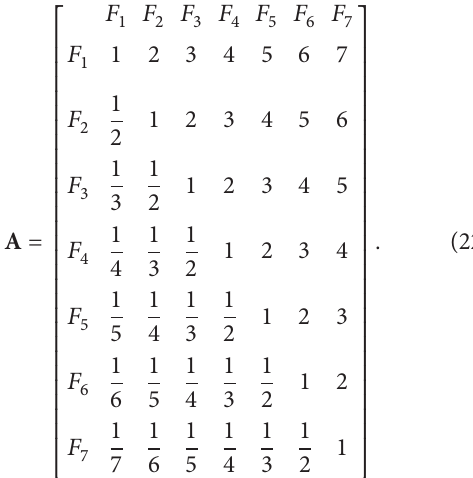
According to the feature scores, the feature sets’ priorities are